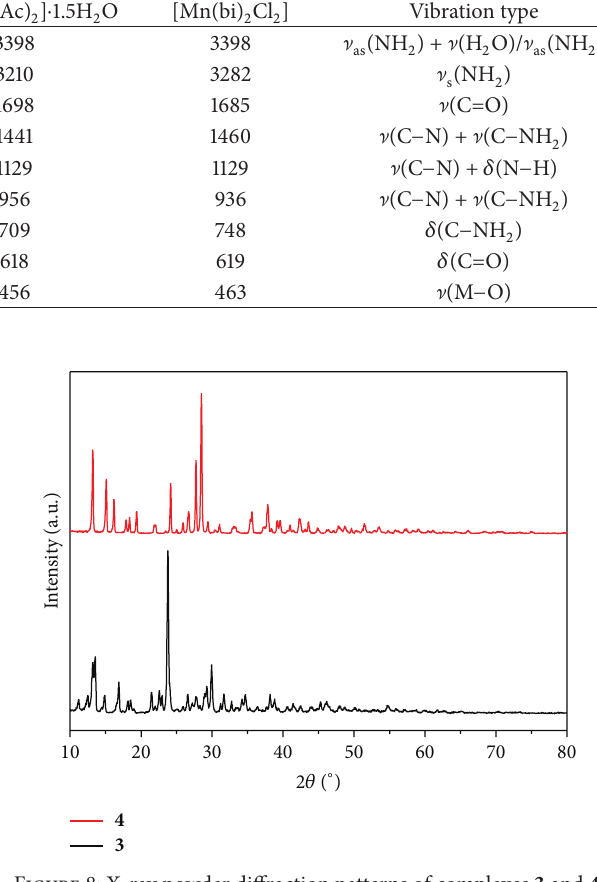
The last weight loss is considered to be the decomposition of nickel acetate (found 23.25%, calcd. 23.36%). As a result, the final residue is nickel oxide. As shown in Figure 11, there are two large weight losses of 60.67% (calcd. 61.40%, loss of